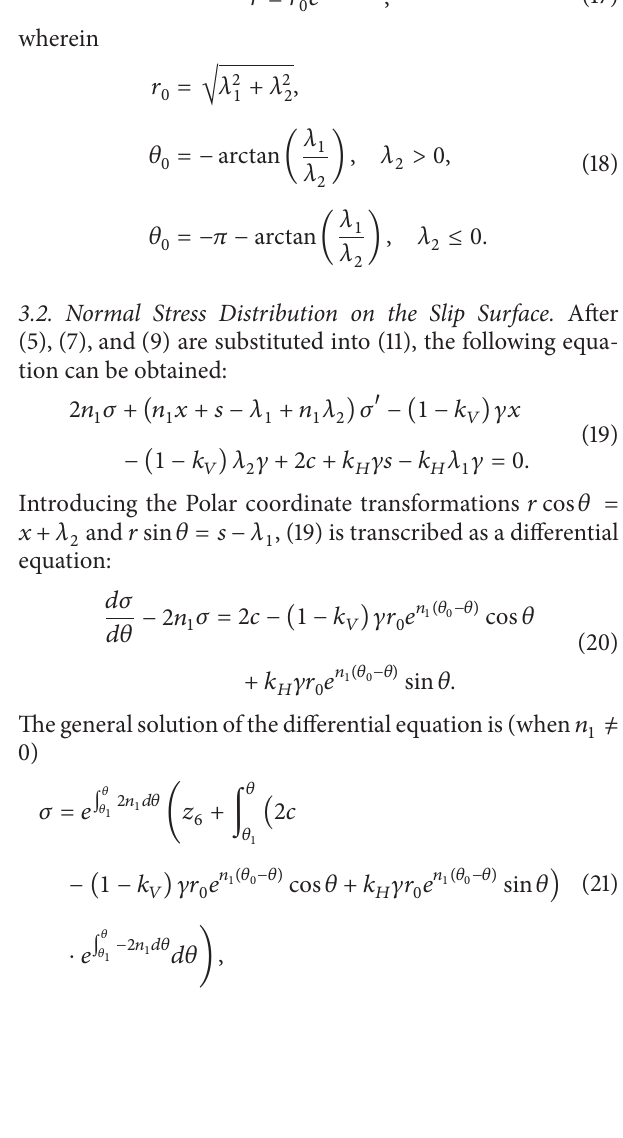
Figure2:Calculationmodelofseismicactiveearthpressureinpolar